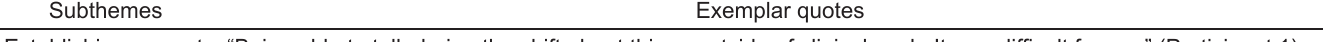
Table 4. Team-dynamic challenges perceived by non-US international medical graduates in emergency medicine residencies: interpersonal